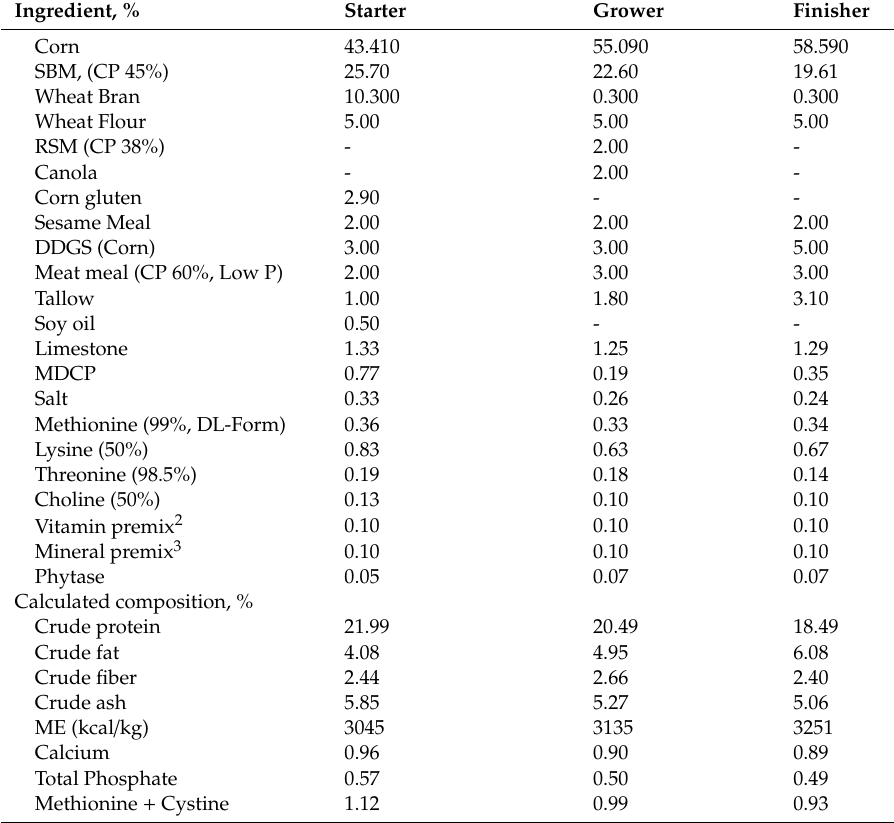
Table 1. Basal diet composition of broilers (as-fed basis) 1